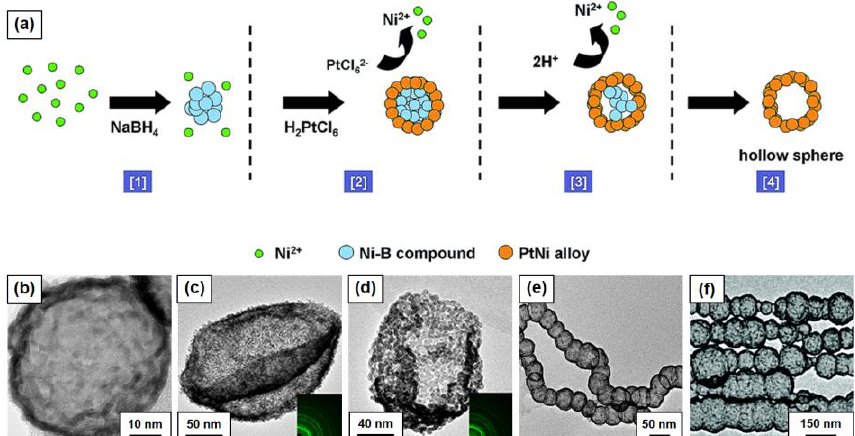
Figure 7. Hollow Pt based NMs with the combination of sacrificial template method and galvanic replacement reaction: ( a ) Schematic illustration for the formation of NiPt hollow spheres, adapted from [105], with the permission from the Royal Society of Chemistry, 2015. TEM images of ( b ) NiPt hollow sphere, adapted from [103], with the permission from the Royal Society of Chemistry, 2011, ( c ) NiPt double-layered nanobowls, adapted from [106], with the permission from Tsinghua University Press and Springer-Verlag BerlinHeidelberg, 2016, ( d ) NiPt single-layered nanobowls, adapted from [106], with the permission from Tsinghua University Press and Springer-Verlag BerlinHeidelberg, 2016, ( e ) CoPt hollow nanochains, adapted from [104], with the permission from American Chemical Society, 2012, and ( f ) FePt oriented hollow nanochains, adapted from [107], with the permission from the Royal Society of Chemistry, 2016.